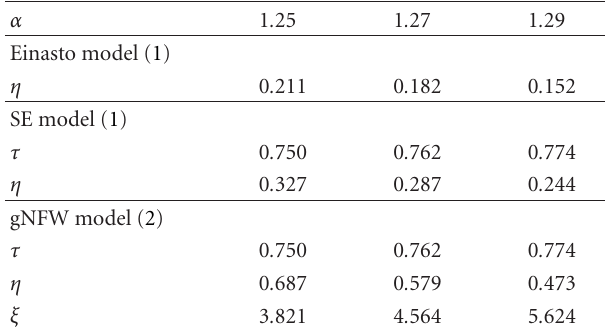
Table 1: Parameters of empirical models in the isotropic case.